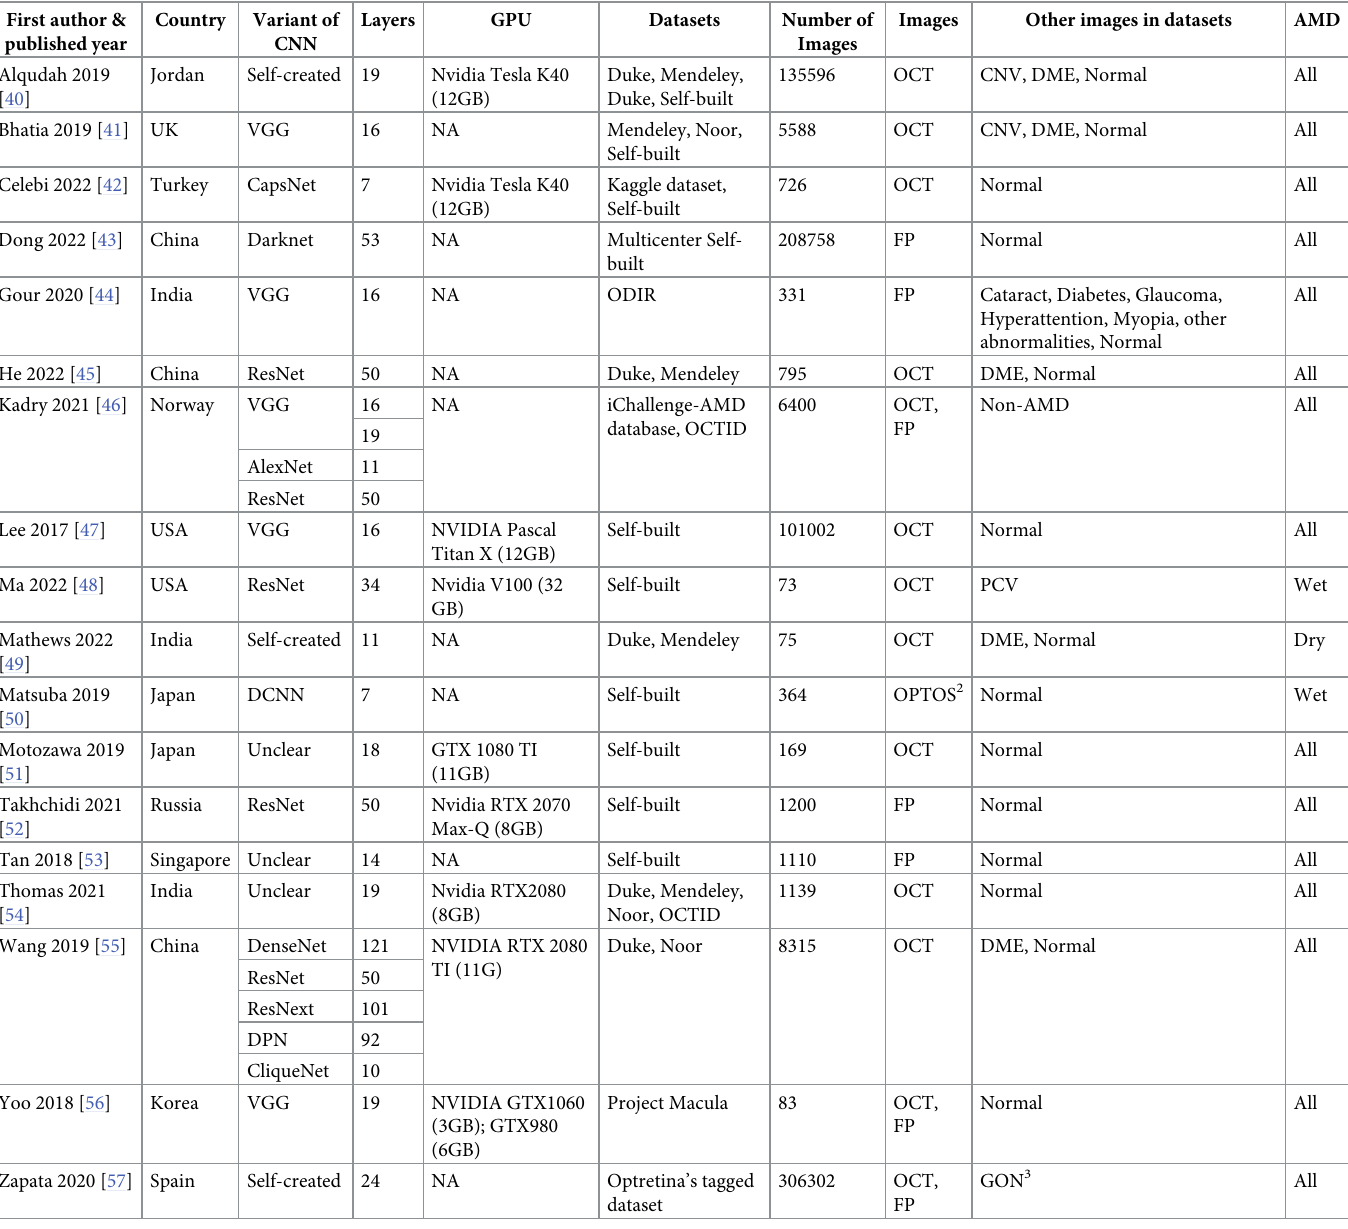
Table 1. Characteristics of included